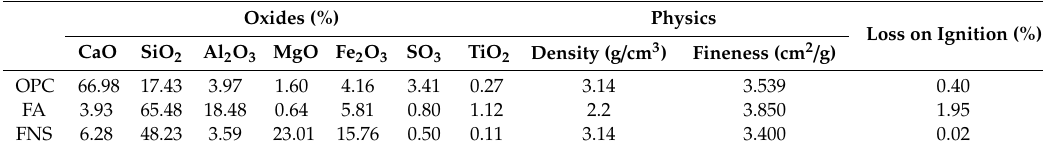
Table 1. Chemical and physical properties of raw materials.